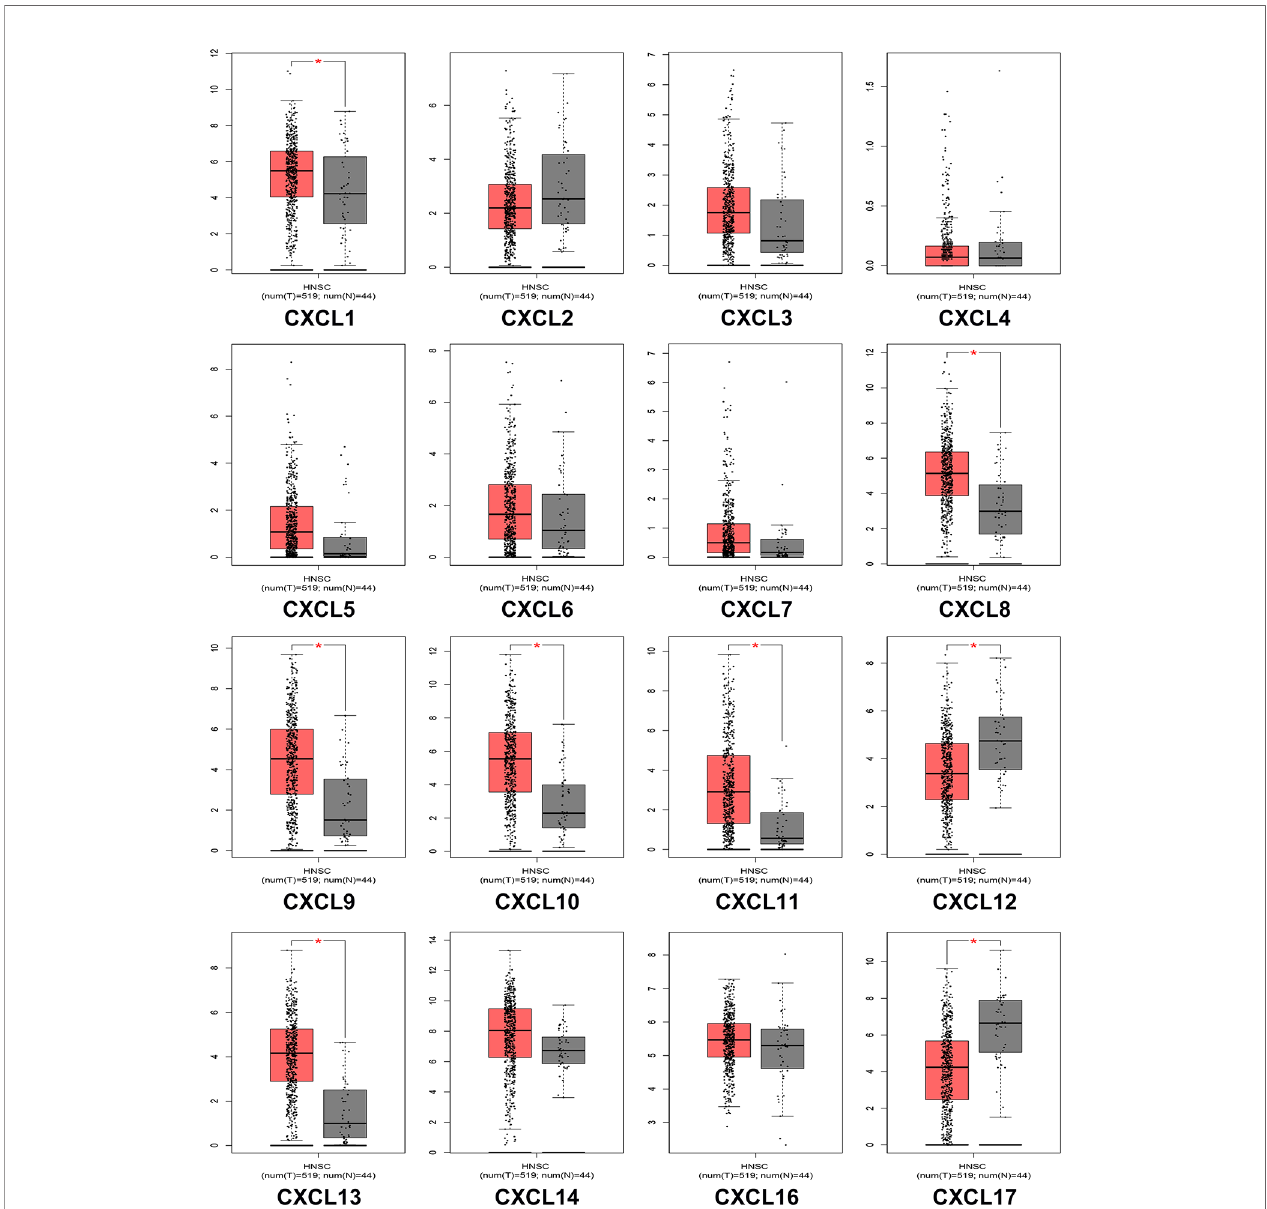
FIGURE 2 | The expression of CXC chemokines in HNSCC patients (GEPIA). The p -value = 0.01. * indicated that the results are statically signi fi